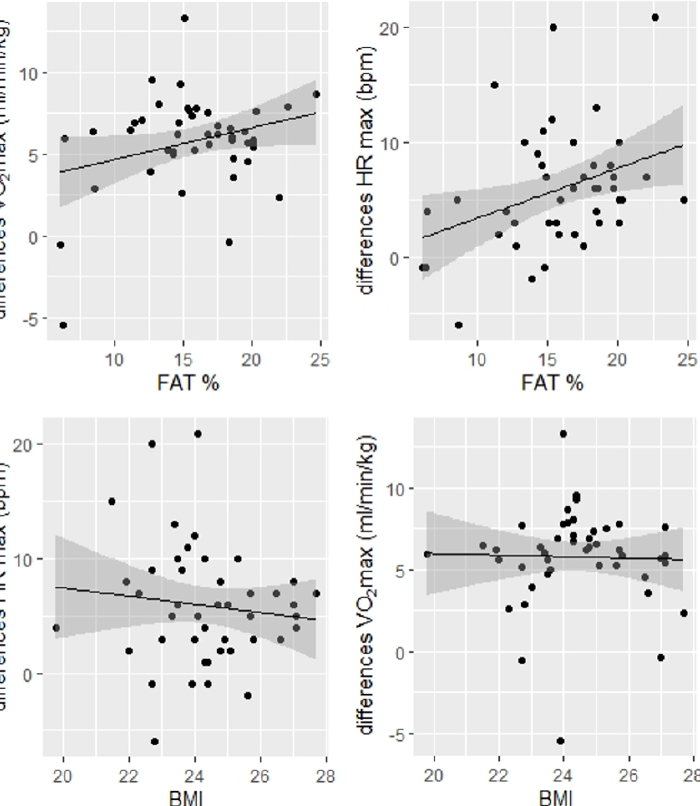
Figure 1. Regression analysis for males in subgroup >40 years. Legend: Multiple linear regression was performed to evaluate the association between differences in treadmill and cycle ergometer test results, and BMI, body fat and fat-free mass in amateur male triathletes. The figure presents the most important (highest R 2 ) relationships in the group of males >40 years of age ( n = 40) as linear regression graphs. Abbreviations: BMI, body mass index (kg/m 2 ); HR max, maximal heart rate (bpm); VO 2 max, maximum oxygen uptake